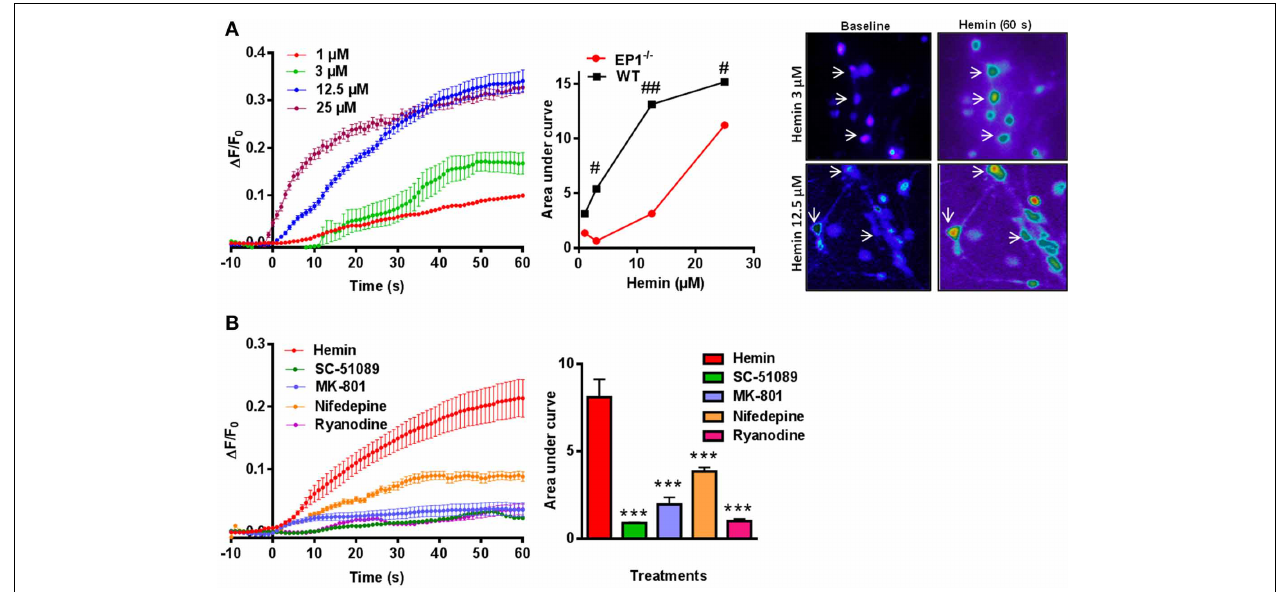
FIGURE 6 | Hemin mediated changes in [Ca 2 + ] i in neurons. (A) (cid:2) F / F 0 induced by hemin (1, 3, 12.5, and 25 μ M) in WT neurons. Plot represents relationship between extracellular concentration of hemin and [Ca 2 + ] i in WT and EP1 − / − neurons. Sequential pseudo color images of representative neurons shows changes in [Ca 2 + ] i in response to hemin (3 and 12.5 μ M) measured using Fluo-8 AM (baseline and hemin for 60s) in WT neurons. # p < 0 . 01; ## p < 0 . 01 compared to the effect of hemin (3, 12.5, and